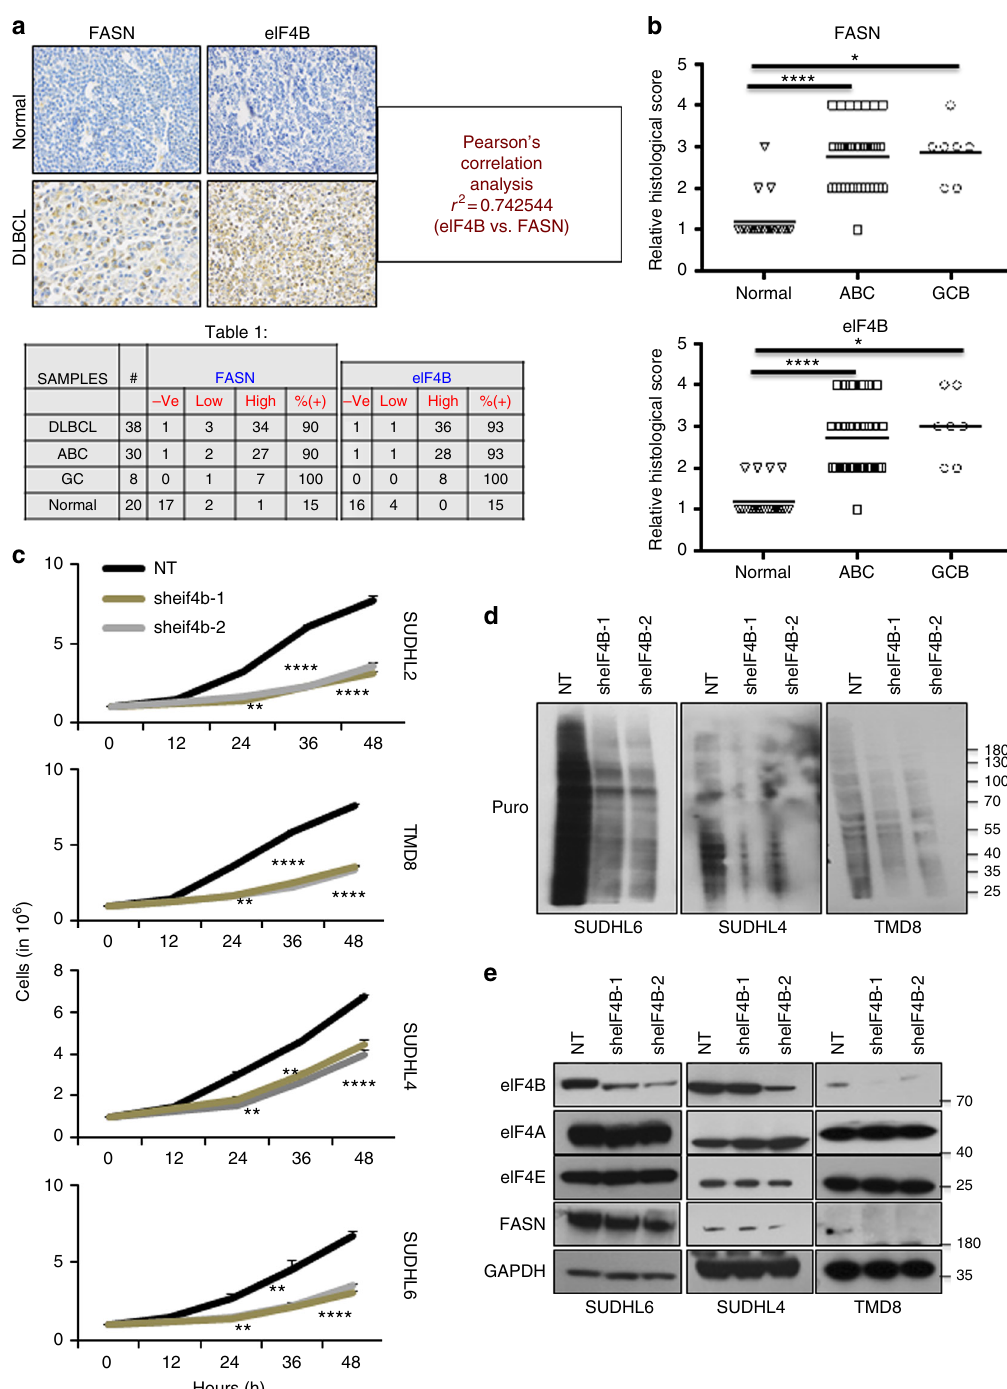
Fig. 2 eIF4B is expressed in DLBCL. a Representative immunohistochemistry image of TMA slides stained with eIF4B and FASN antibodies. Summary of the eIF4B and FASN stained slides for DLBCL samples. b Representative scatter plots showing the stained signals of FASN and eIF4B in normal ABC and GC-DLBCL samples. Statistical analysis was performed using Wilcoxon signed-rank test (unpaired two-tailed), * p <0.05, **** p <0.001 vs. normal samples. c Indicated eIF4B depleted stable cells were seeded 1 million per well in 6-well plates. Post 12h, the cells were collected and counted using trypan blue. Values are expressed as mean±SD ( n = 3), ** p ,0.01, **** p <0.001 vs. NT infected corresponding cells. d , e Indicated cells were infected by shRNA against eIF4B and cultured in puromycin (0.5 – 1 µ g/mL) for stable cells generation. Post selection, cells were exposed for 30min with puromycin treatment (3 µ g/mL) and lysed. Cell lysates were subjected to immunoblotting with the anti-Puro antibody (SUnSET assay) ( d ) or indicated antibodies ( e ). GAPDH was used as loading protein biosynthesis (Fig. 2d, Supplementary Figures 5B, 7). eIF4B regulates protein abundance of oncogene . The signi fi cant reduction in cellular proliferation coupled with decreased nascent peptide biosynthesis upon eIF4B depletion led us to interrogate